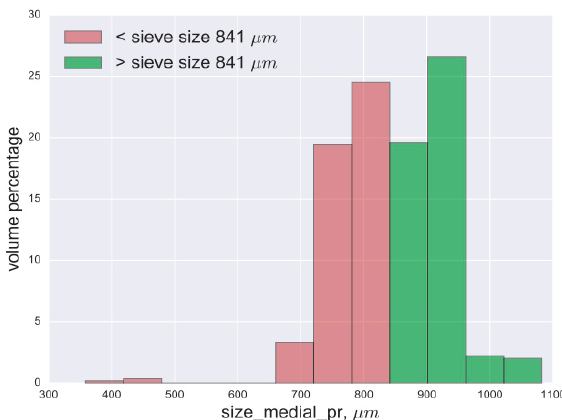
Figure 19. Volume-weighted grain size distribution for CarboProp NRT 16/30 by our method.